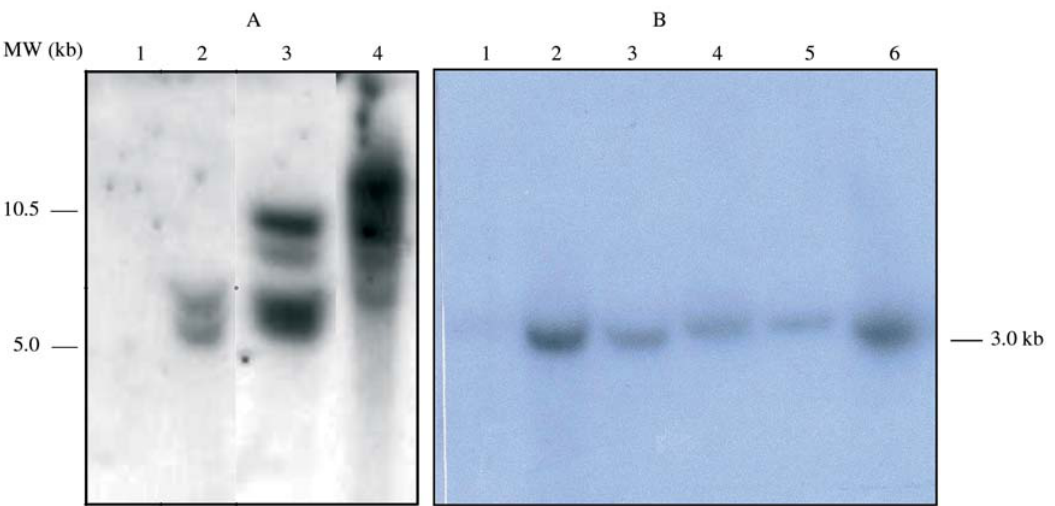
Figure 3 - Southern blot of sorghum genomic DNA isolated from T 0 and T 1 plants transformed with Agrobacterium tumefaciens LBA4404 (pTOK233). DNAfromallplantswasdigestedwith Hind III.(A)DNAwashybridizedwith hpt probe.Lane1,DNAfromT 0 non-transformedplant.Lanes2,3,and4, DNA from T 0 transformed plants 687, 163 and 91, respectively. Single cut with Hind III in the T-DNA shows two copies of the transgene in plant 687 and three in plant 163. (B) DNA was hybridized with gusA. Lane 1, DNA from non-transformed plant. Lanes 2 to 7, DNA from T 1 transformed plants derived from plant 687. After digestion with Hind III the expected 3.14-kb fragment was